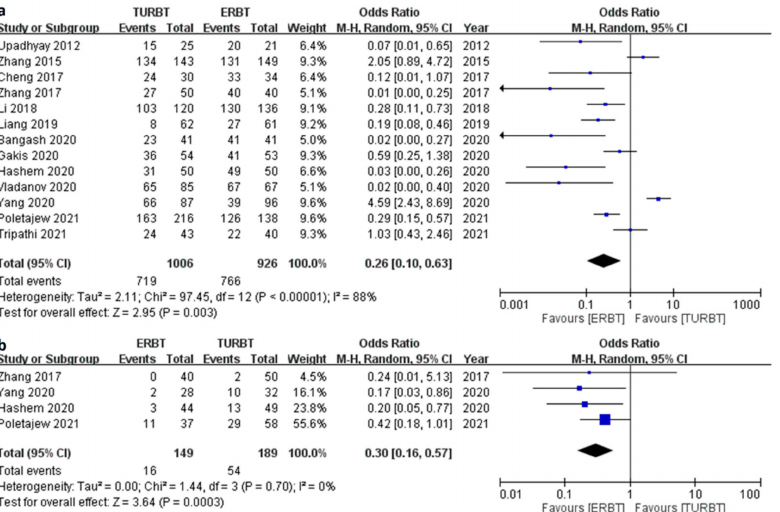
Figure 2. The forest plot of tumor complete resection outcome between the two groups. ( a ) Forest plot of identification of detrusor muscle. ( b ) Forest plot of residual tumor rate.